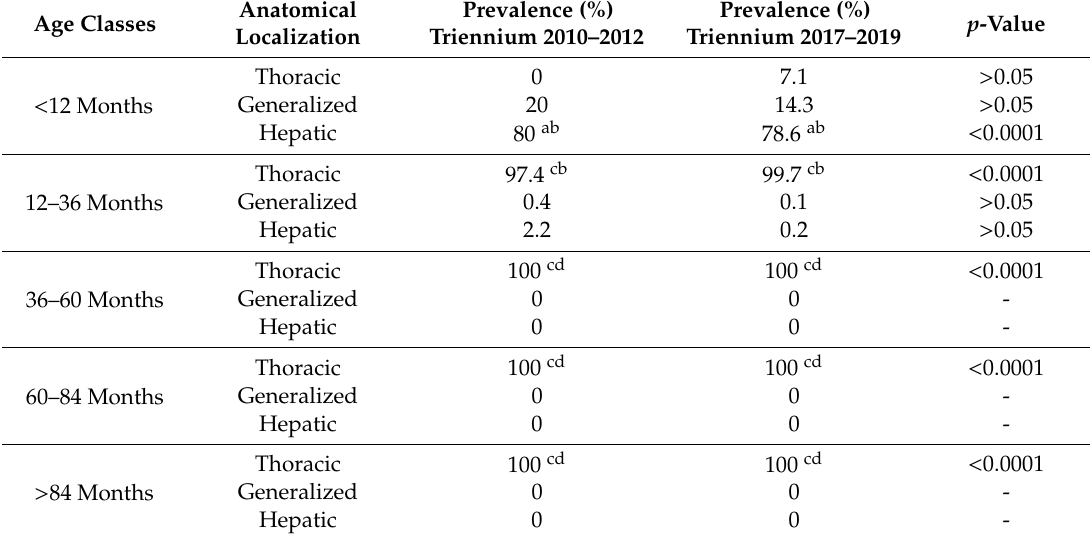
Table 1. Prevalence of gross lesions (%), together with statistical significances, found among the anatomical sites studied in cattle of di ff erent age classes slaughtered during the overall study period ( n = 54,751 animals during the triennium 2010–2012; n = 45,445 animals during the triennium